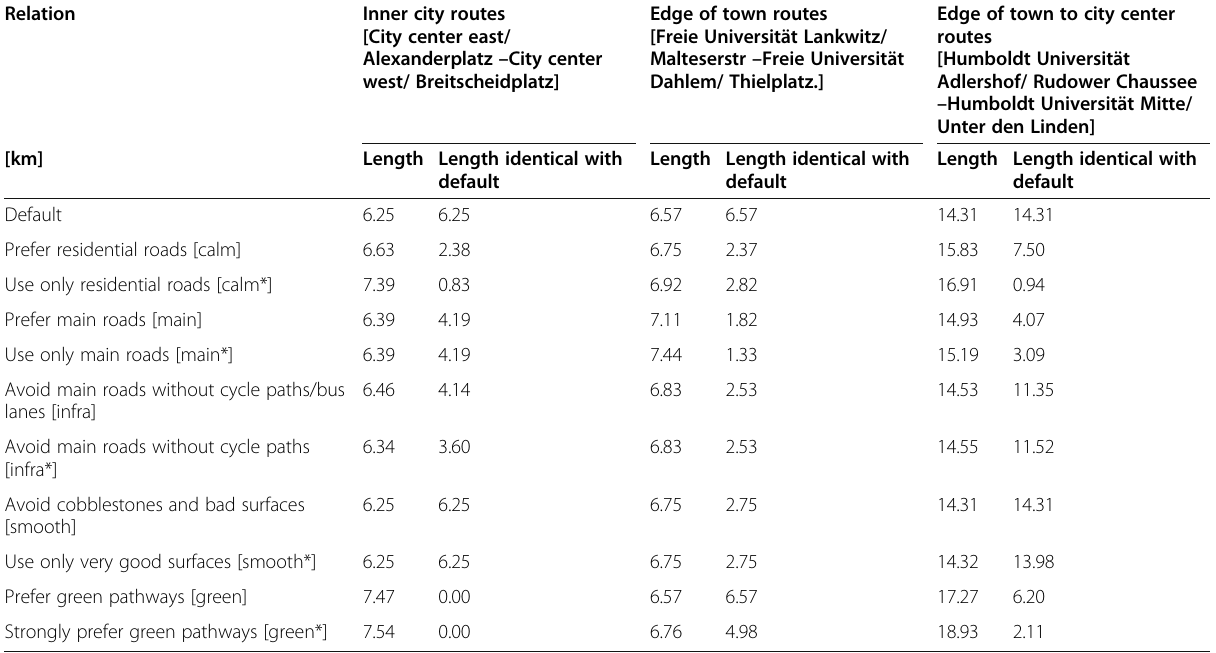
Table 4 Comparison of length and overlap for exemplary routes